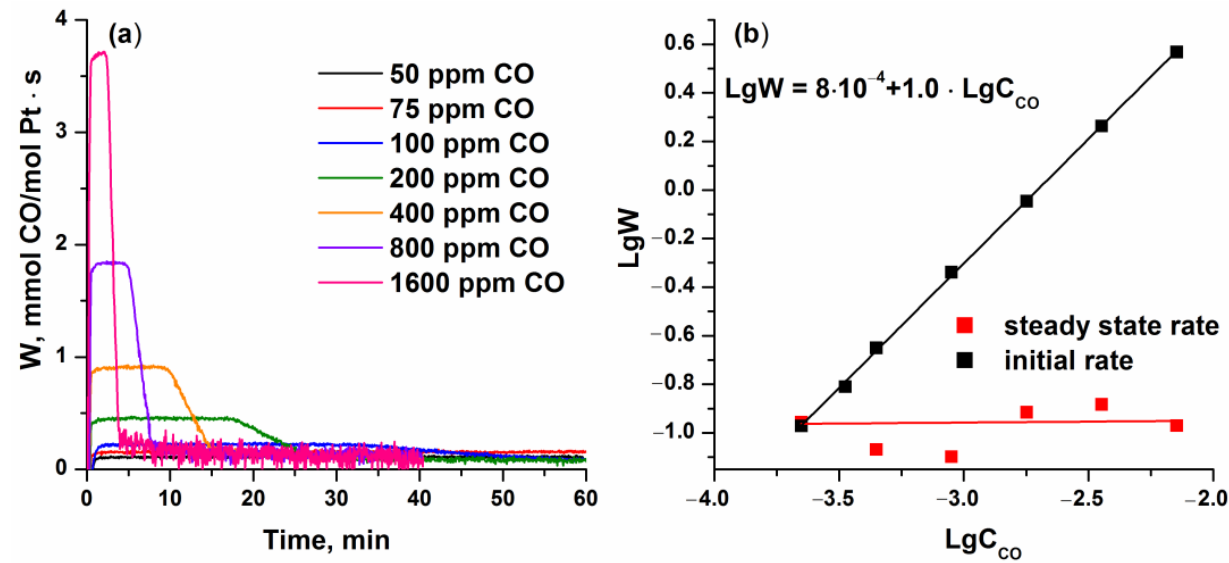
Figure A1. ( a ) CO conversion and ( b ) CO 2 production versus time for an experiment with initial CO concentration of 50 ppm at 25 °C.